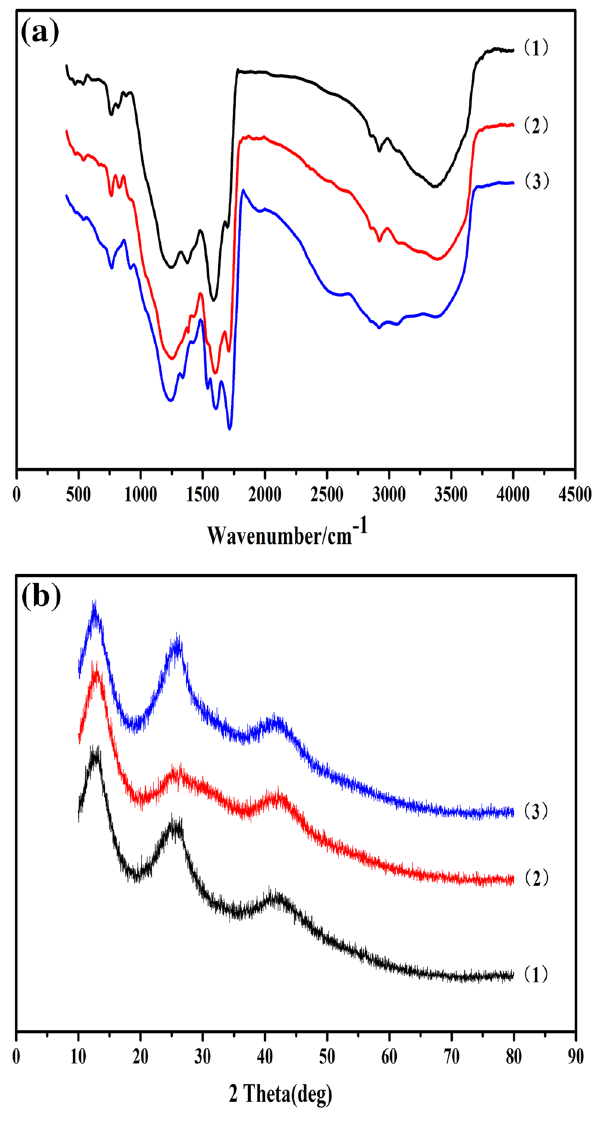
Fig. 1 FT-IR ( a ) and XRD ( b ) spectra of coal and its pretreatment (1) coal, (2) Coal mild stirring in HNO 3 at room temperature for 24 h, (3) Coal stirring for 24 h of reflux after mild stirring in HNO 3 at room temperature for 24